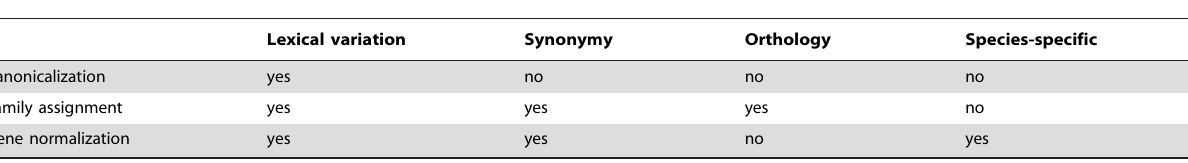
Table 2. Normalization methods and their